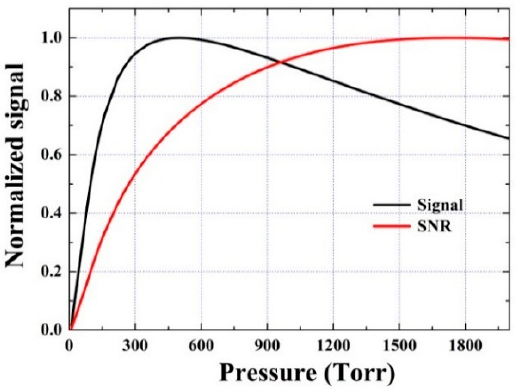
Figure 8. QEPAS sensor performances in terms of signal amplitudes and SNR predicted by the developed relaxation model for detecting CO in dry N 2 .